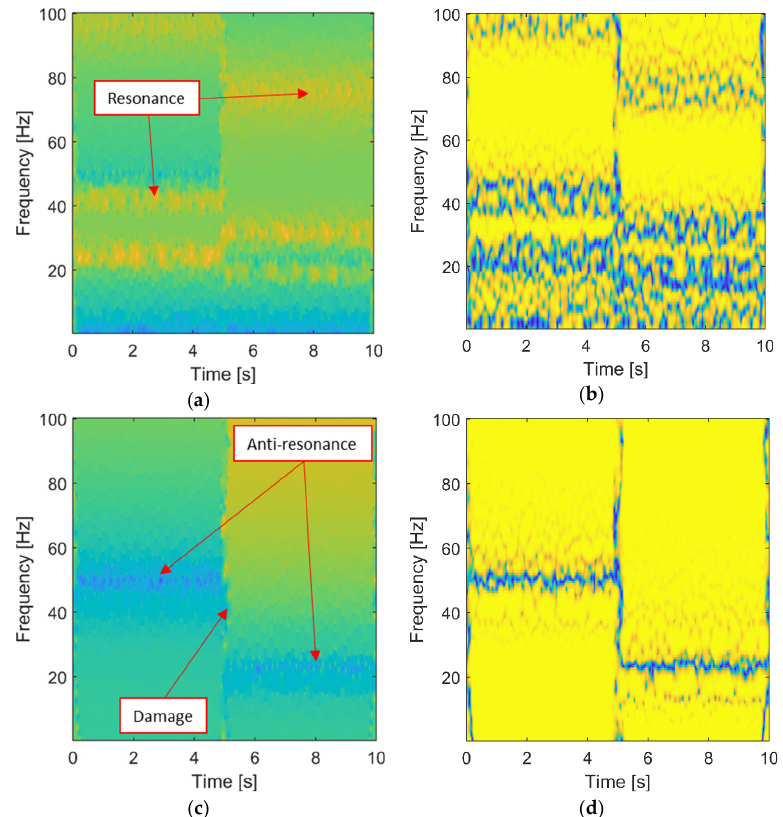
Figure 3. Wavelet-based analysis for the simulated LTV system: ( a ) wavelet-based FRF in logarithmic scale; ( b ) wavelet-based FRF coherence; ( c ) wavelet-based transmittance; ( d ) wavelet-based transmittance coherence.